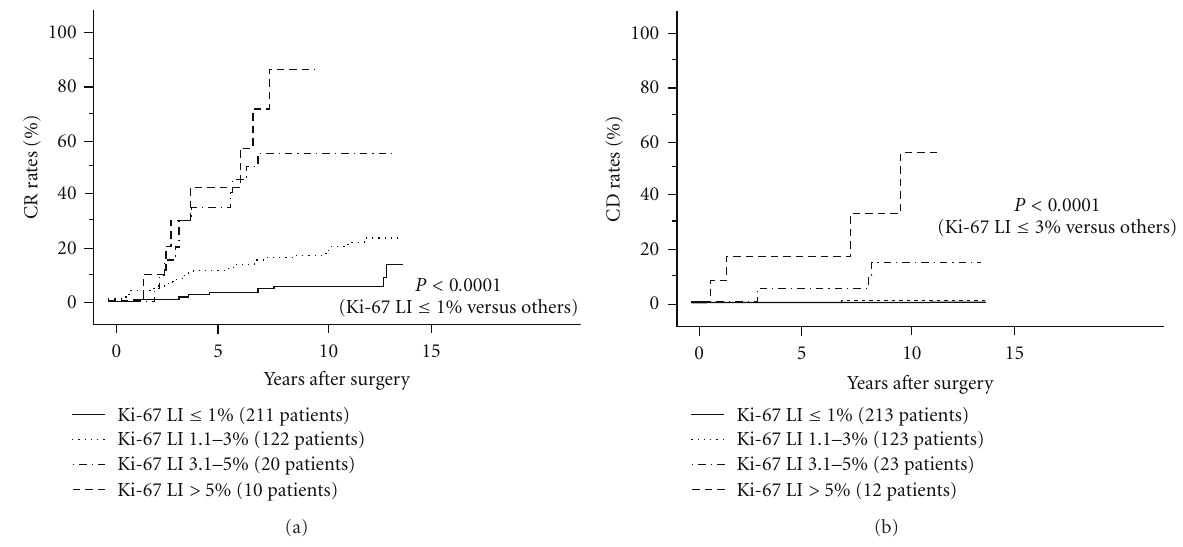
Figure 9: CR rates of PTC patients with Ki-67 1% or less, 1.1–3%, 3.1–5%, and greater than